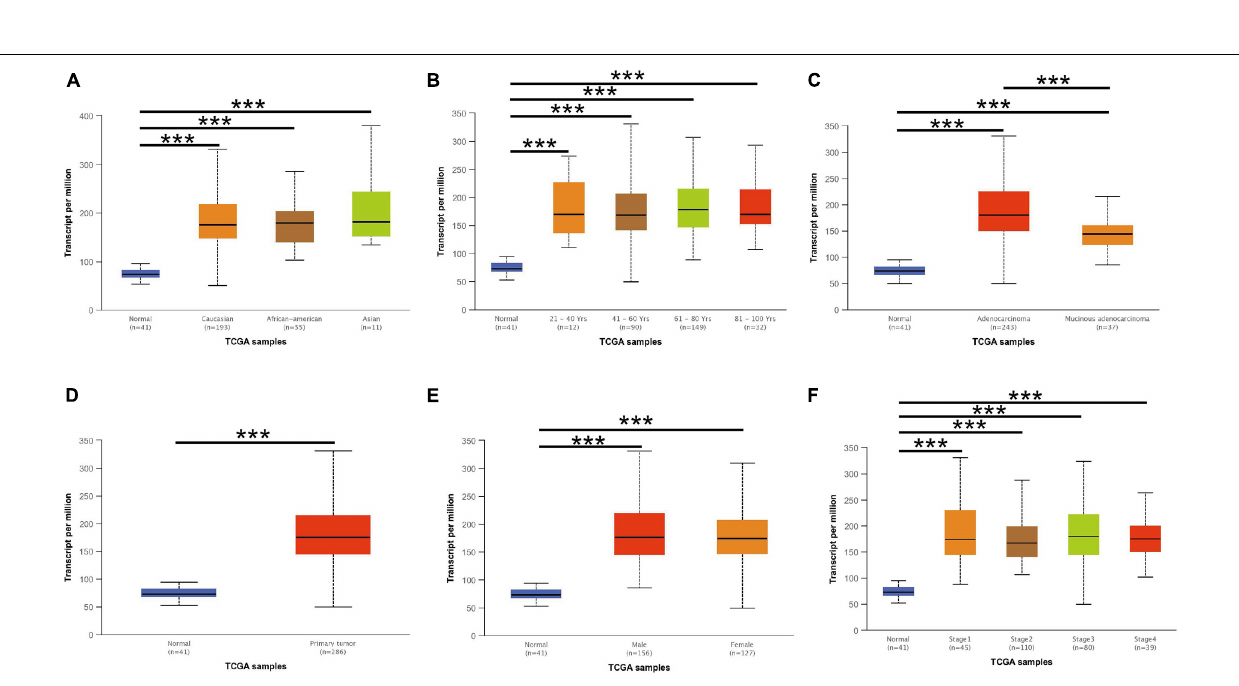
FIGURE 2 | CCT6A transcription in subgroups of patients with COAD, stratified based on race, age, and other criteria (UALCAN). (A) Boxplot showing relative expression of CCT6A in normal and COAD samples. (B) Boxplot showing relative expression of CCT6A in normal individuals of either gender or male or female COAD patients. (C) Boxplot showing relative expression of CCT6A in normal individuals of any age or COAD patients aged 21–40, 41–60, 61–80, or 81–100 year. (D) Boxplot was showing relative expression of CCT6A in normal individuals of any ethnicity or COAD patients of Caucasian, African-American or Asian ethnicity. (E) Boxplot showing relative expression of CCT6A in normal individuals or COAD patients in stages 1, 2, 3, or 4. (F) Boxplot showing relative expression of CCT6A in normal individuals or COAD patients with grade 1, 2, 3, or 4 tumors. Data are mean ± SE. *** P <